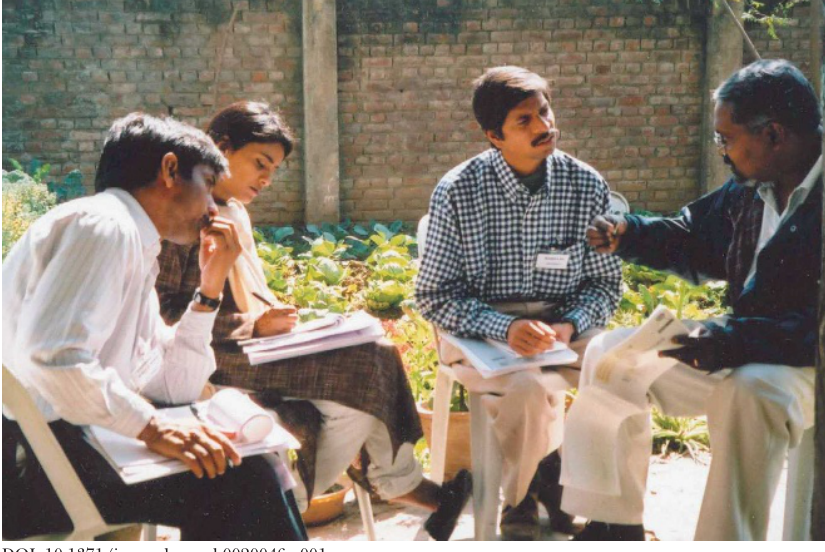
Figure 1. Participants Discussing a Topic on Leadership Styles during a PILLARS Workshop in